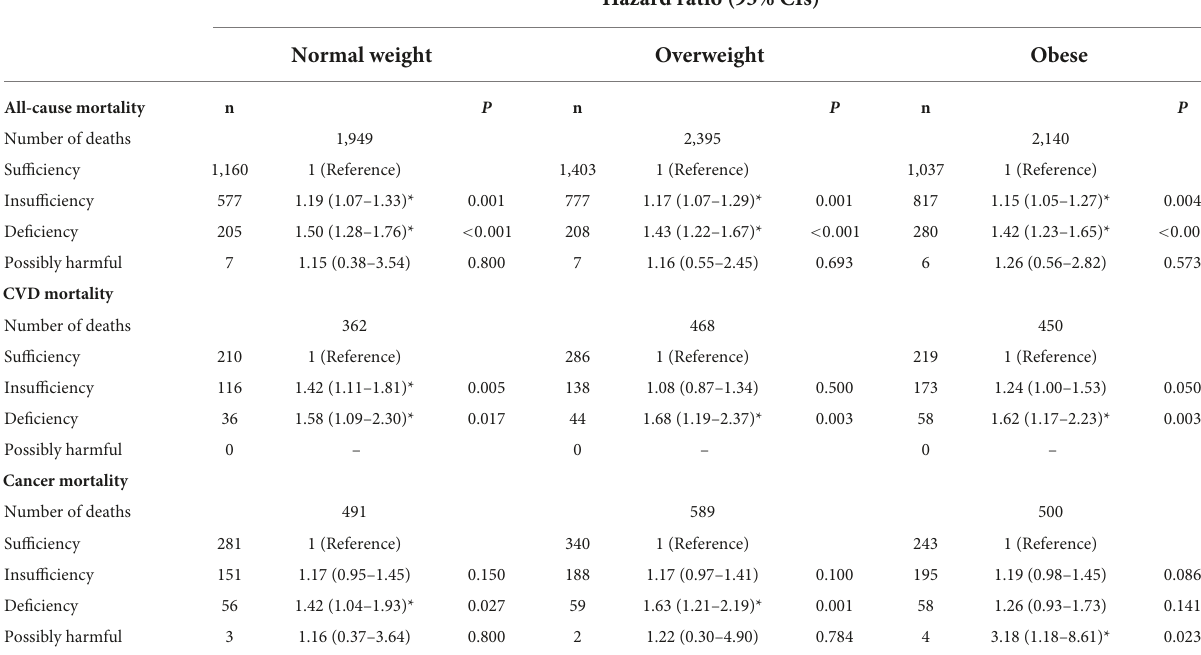
TABLE 5 Stratified HRs (95% CIs) across different BMI categories and additive effect of serum 25(OH)D status on all-cause and cause-specific mortality in NHANES III and NHANES 2001–2014. Vitamin D status BMI Hazard ratio (95% CIs) Normal weight Overweight